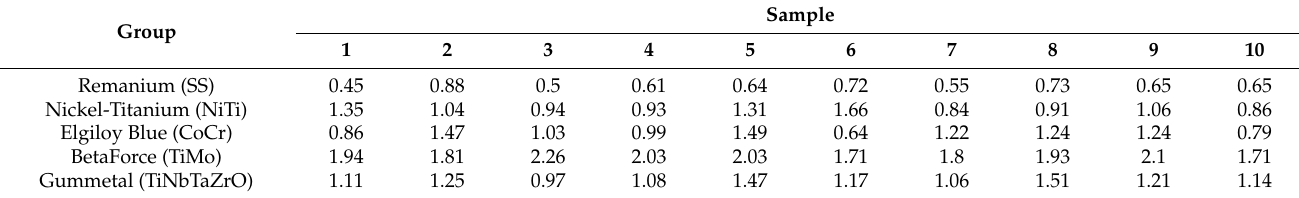
Table 2. Descriptive statistics of kinetic FF by group sample means (unit; N).